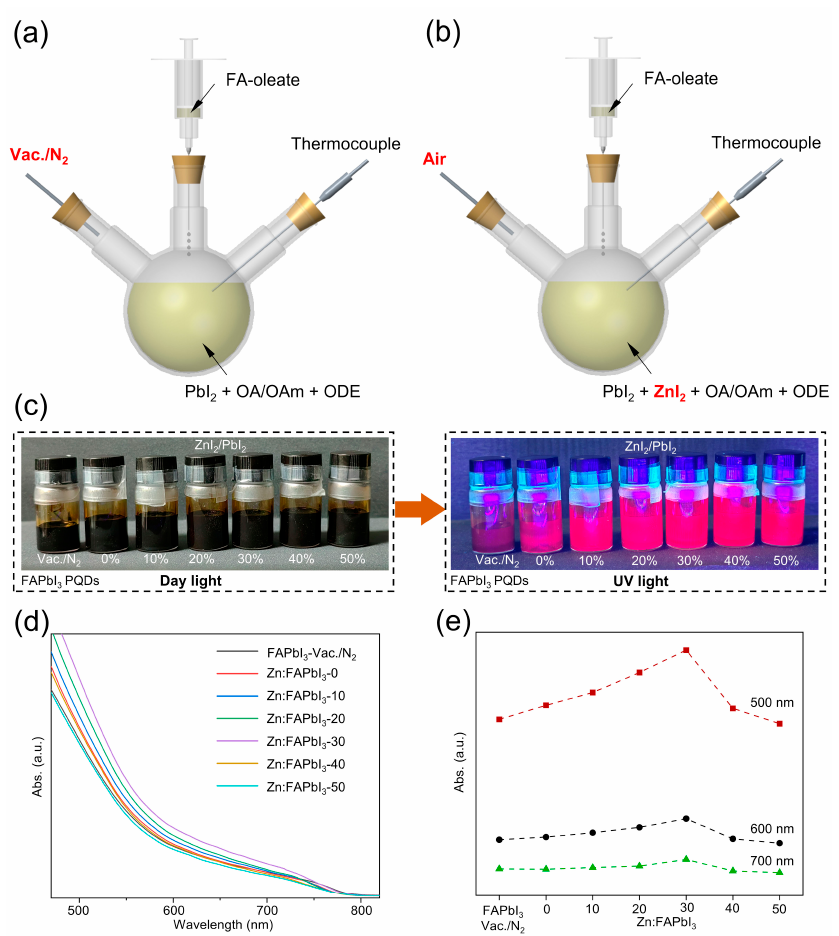
Figure 1. Scheme of the hot injection of FAPbI 3 PQDs under N 2 ( a ) and in air ( b ). Photographs of FAPbI 3 PQDs solutions with same concentrations but different synthesis conditions under daylight and UV light ( c ). The UV-Vis spectra ( d ) and the absorbance at 500 nm, 600 nm, and 700 nm ( e ) for FAPbI 3 -vaccum/N 2 , Zn:FAPbI 3 -0, Zn:FAPbI 3 -10, Zn:FAPbI 3 -20, Zn:FAPbI 3 -30, Zn:FAPbI 3 -40, and Zn:FAPbI 3 -50